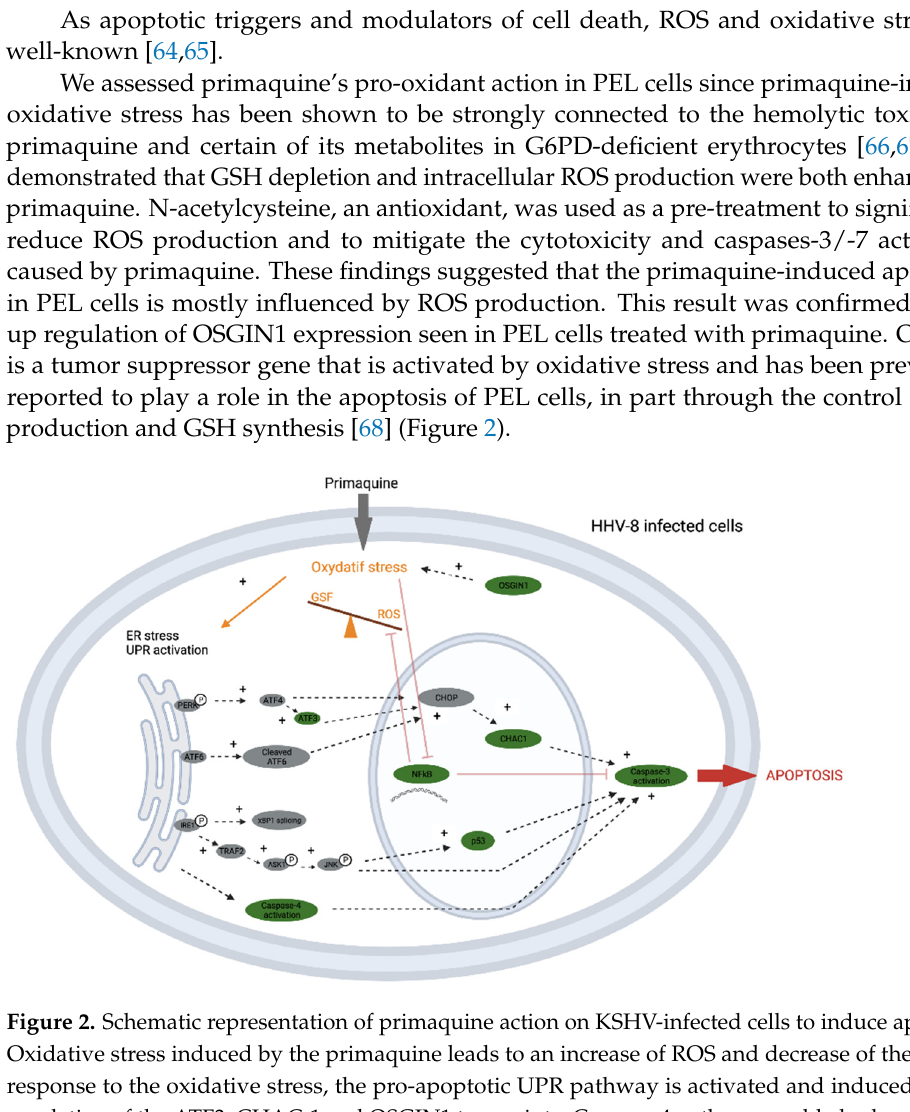
replication was not necessary for primaquine’s induction of cell death. RNA-seq investigation brought to light the activation of some hallmarks of the endo- plasmic reticulum (ER) stress-mediated apoptosis signaling pathway as we studied the cell death signaling pathways associated with primaquine modes of action. The increased protein requirement of cancer cells can cause ER stress and, as a result, the unfolded pro- tein response (UPR) to maintain ER homeostasis, which promotes tumor cell survival due to their accelerated rate of growth and proliferation [69,70]. However, the pro-apoptotic pathways of the UPR are activated, including the production of the pro-apoptotic tran- scription factor CHOP and activation of caspase-4, which results in apoptosis if the ER stress is too severe, persistent, or cannot be addressed [71–75]. As a result, ER stress-